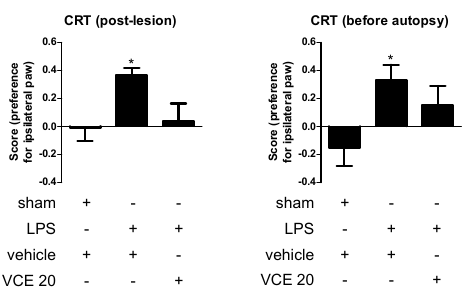
Figure 2. Preference for the ipsilateral paw measured in the cylinder rearing test in control and LPS-lesioned mice orally treated for 28 days after lesion with vehicle (corn oil) or VCE-003.2 at the dose of 20 mg / kg (VCE 20). Data correspond to only one week after the onset of the treatment (post-lesion), or to only one day before the autopsy and after four weeks of treatment (before autopsy). Values are means ± SEM of more than six subjects per group. Data were assessed using the one-way analysis of variance followed by the Bonferroni test (* p < 0.05 versus vehicle-treated control (sham) mice).